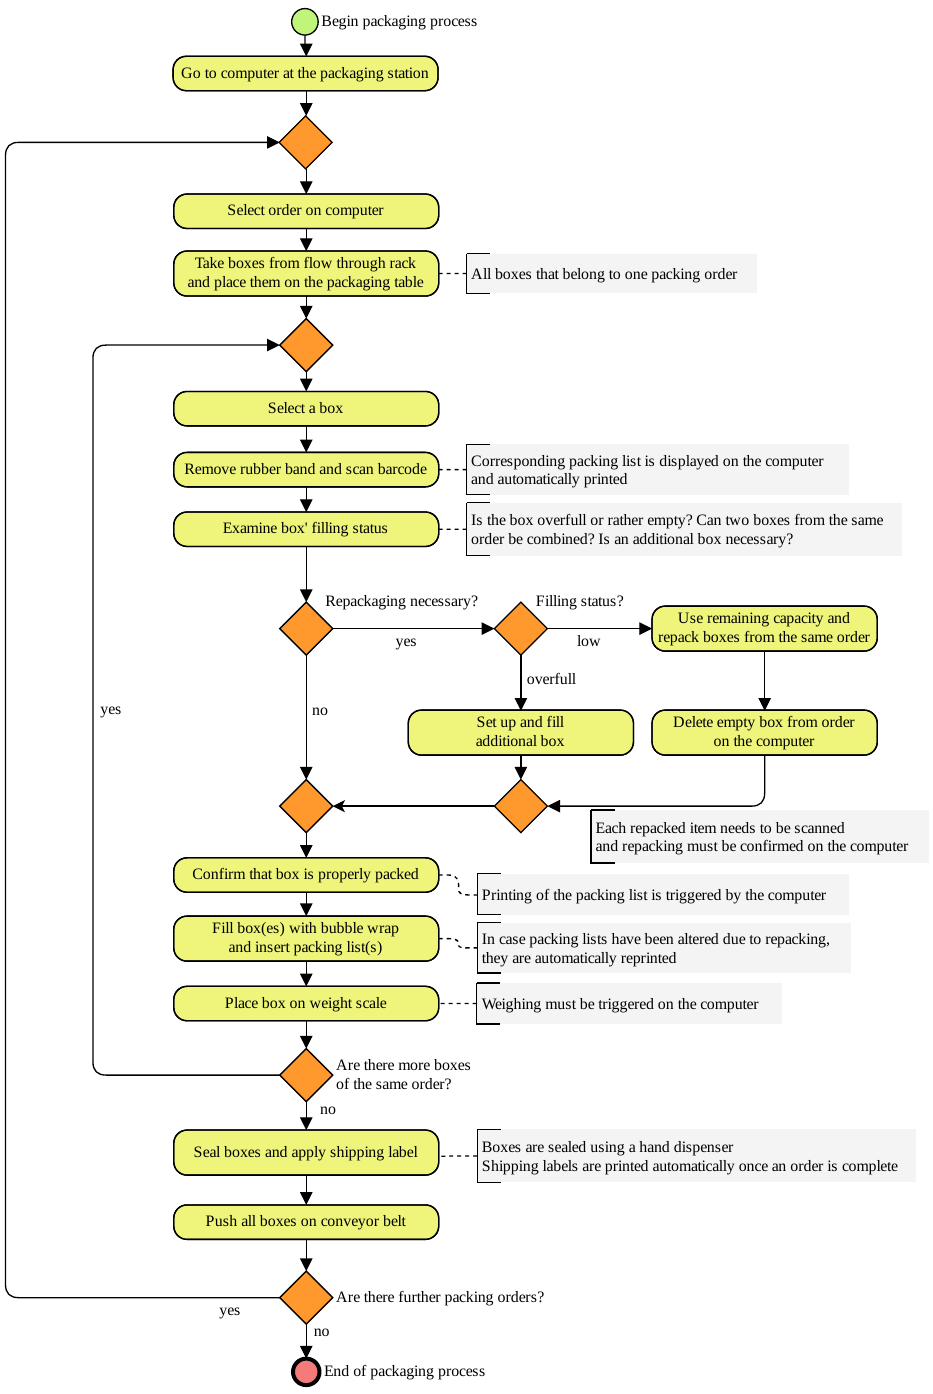
Figure 6. Business process model of logistics Scenario 3—real warehouse packaging work